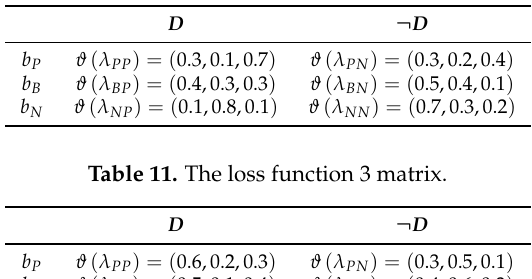
Table 10. The loss function 2 matrix.